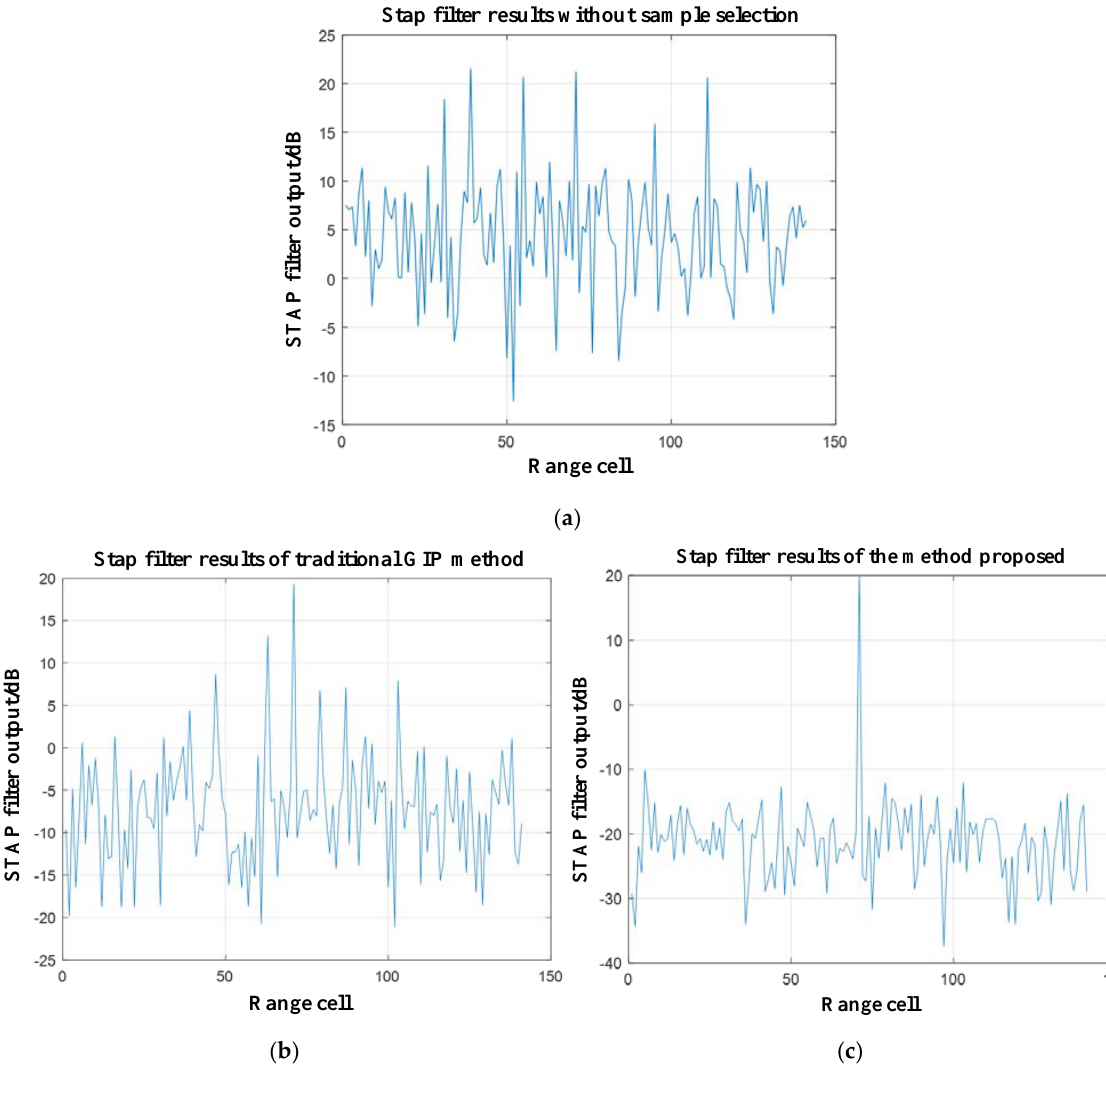
Figure 7. The simulation results of the STAP filter, they should be listed as: ( a ) without sample selection; ( b ) with the traditional GIP method; ( c ) with the method proposed in this paper.